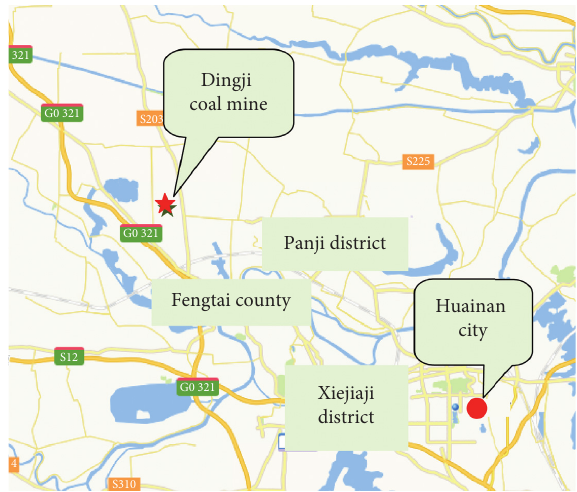
Figure 1: Location map of Dingji coal mine.